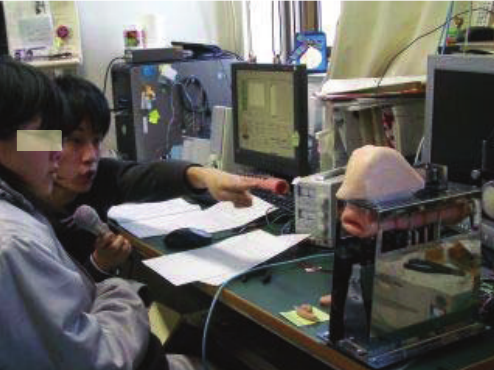
Figure 6: Flowchart of training of speech articulation. Figure 7: Training of speech articulation by auditory-impaired